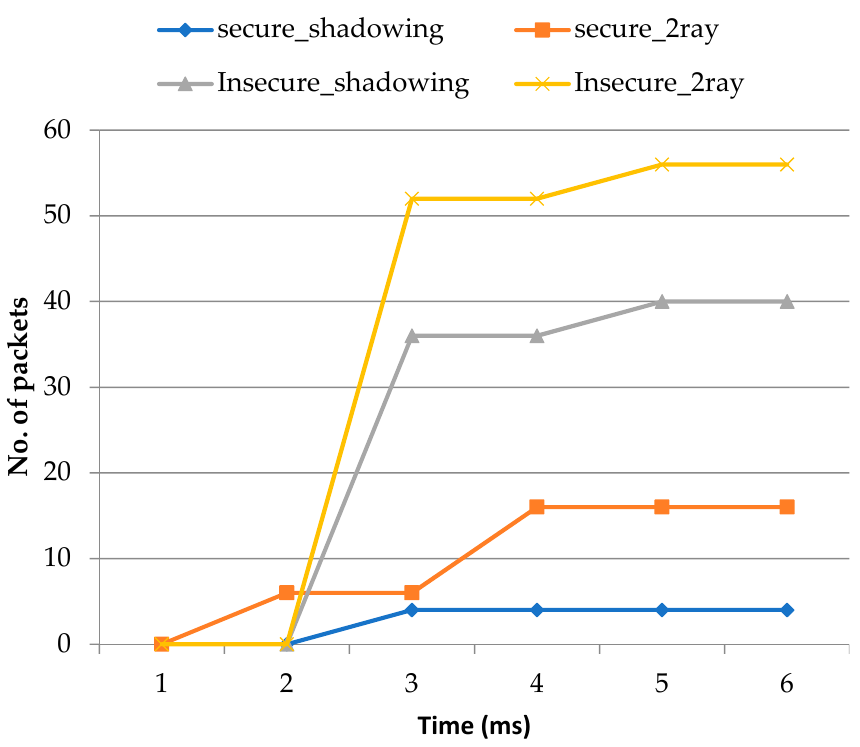
Figure 8. End-to-end delay of flying nodes in the network. Table 7. The number of packets versus time in the end-to-end delay parameter. Secure vs.